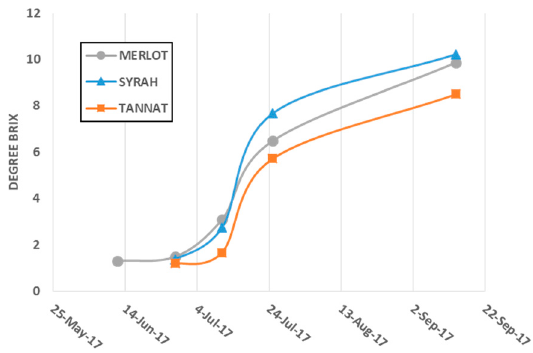
Figure 6. Degree brix evolution of Merlot, Syrah and Tannat grape during ripening.